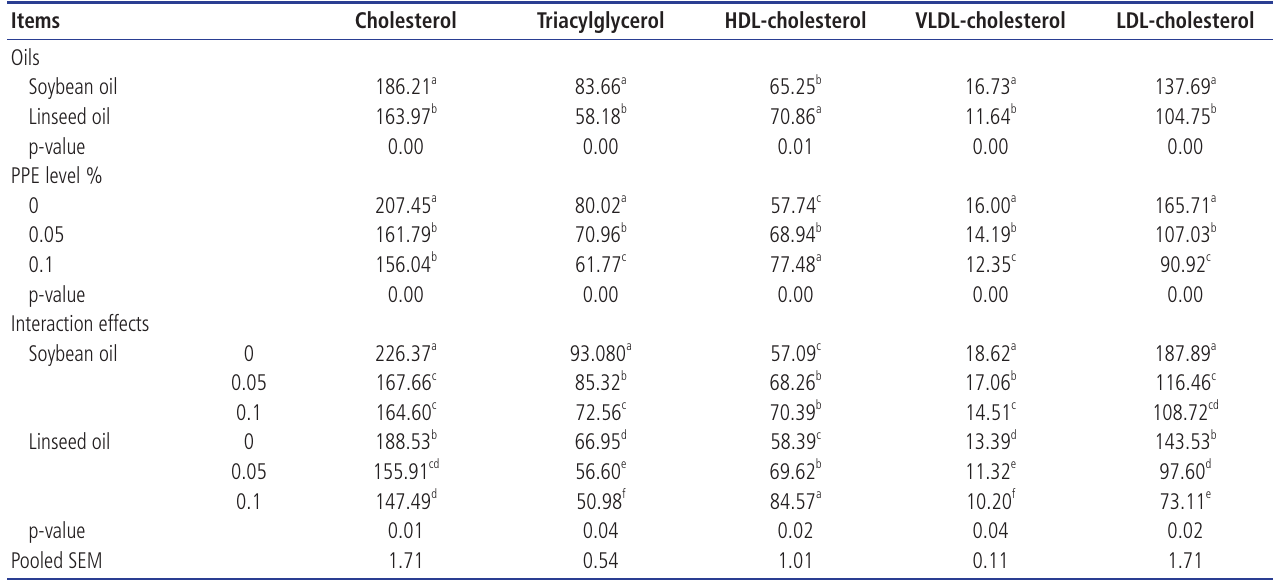
Table 7. Effects of different dietary levels of pomegranate peel extract with different oil sources and their interactions on broiler chickens’ serum lipid profile (mg/dL) Items